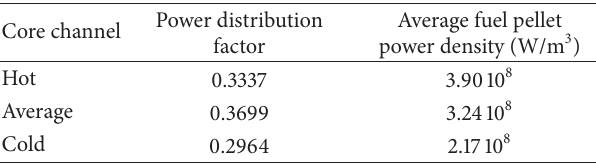
Table 1: Power distribution factors for representative channels and average pellet